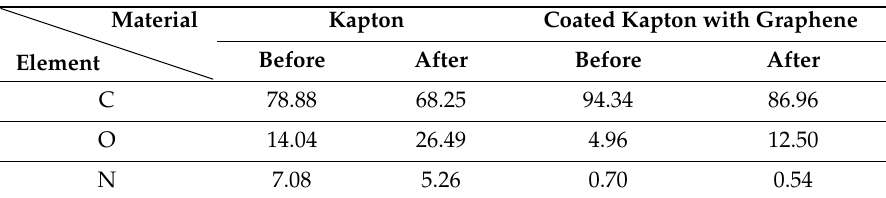
Figure 11. XPS of coated Kapton with a graphene loading of 26.0 µ g / cm 2. ; ( a ) before AO erosion ( b ) after AO erosion (7.09 × 10 20 atoms / cm 2 ). Table 1. Surface composition of Kapton and coated Kapton with graphene loading 26.0 µ g / cm 2 before and after AO erosion (7.09 × 10 20 atoms / cm 2 ) (%).